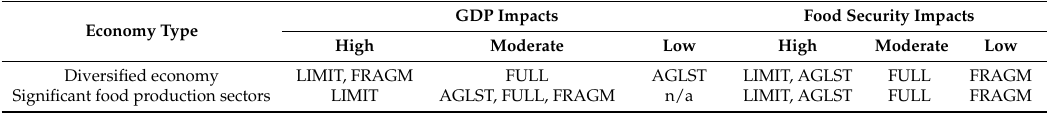
Table 4. GDP and food security impacts comparison across economy types by water allocation